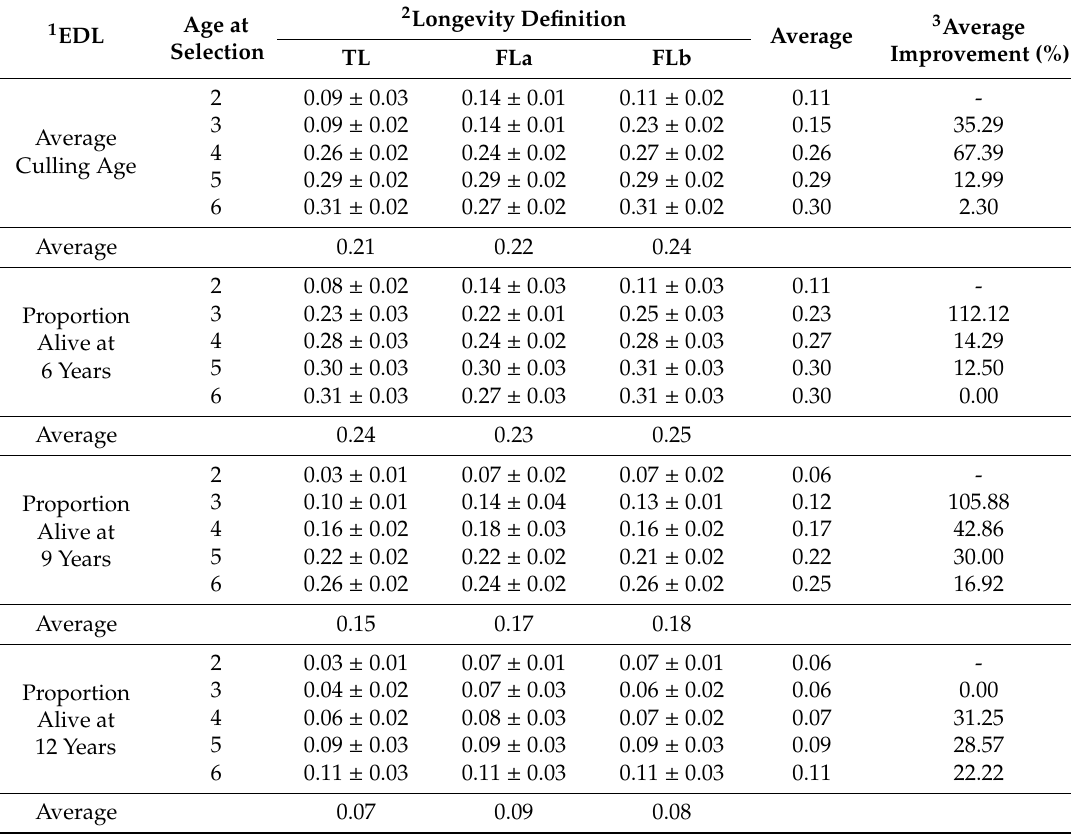
Table 8. Average ( ± SE) prediction accuracy of the expected daughter longevity (EDL) using di ff erent ages at selection (from 2 to 6 years-old), for all longevity definitions.